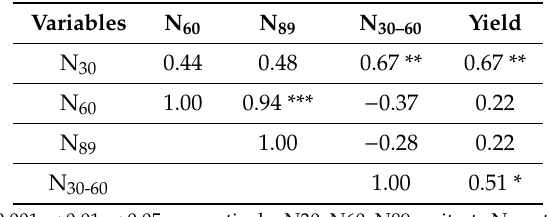
Table A1. Spearman’s coe ffi cients of correlation between nitrate N contents at cardinal stages of WOSR growth and yield, n =